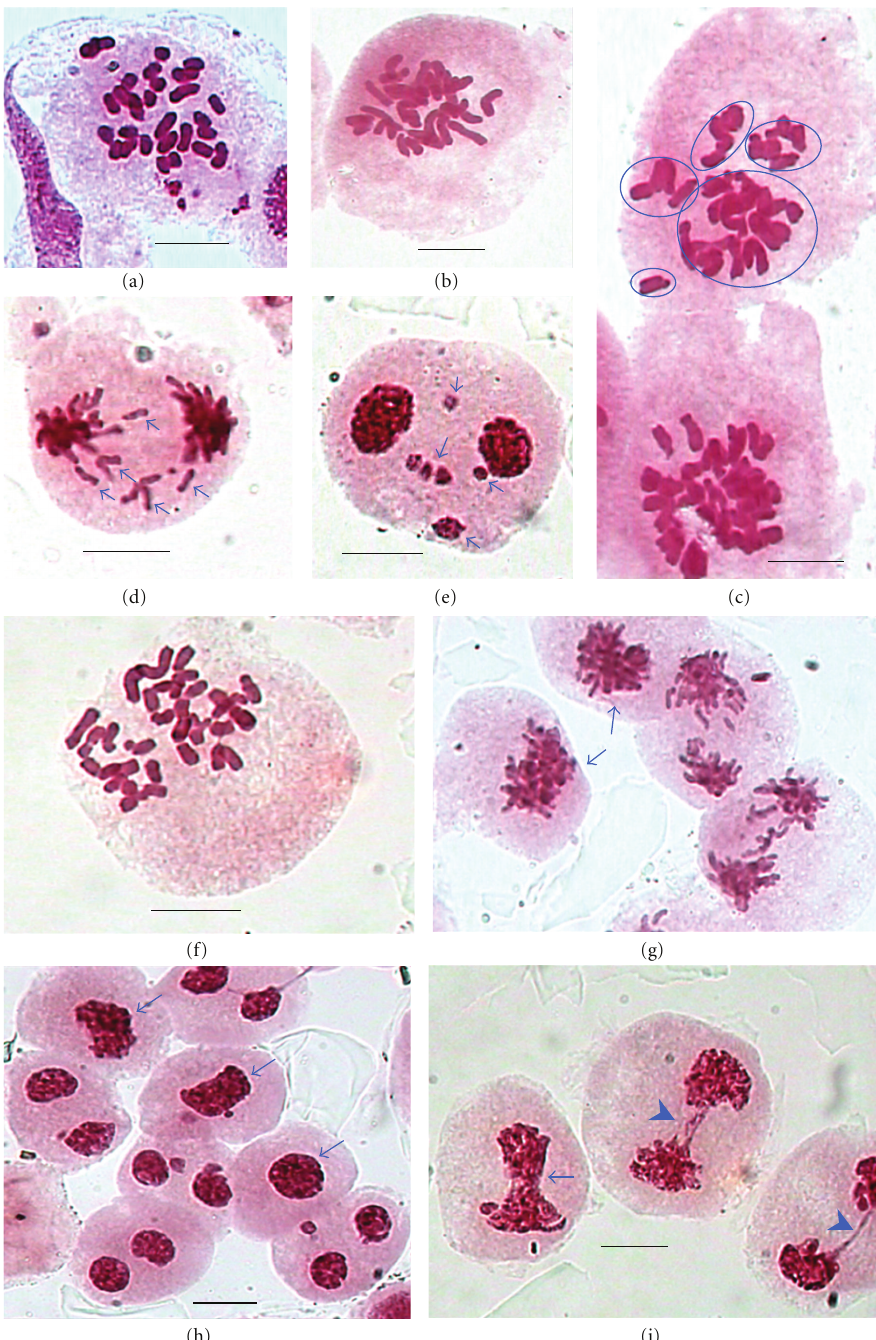
Figure 3: (a–i) Meiocytes with erratic male meiosis at first meiotic division in R. laetus. (a) A PMC with 28 randomly dispersed univalent chromosomes at M-I. (b) 28 univalent chromosomes positioned towards the periphery of PMC at M-I. (c) In one of the PMC univalent chromosomes lying in groups (encircled) and in an adjacent PMC in a single group in the centre. (d) A PMC at A-I with lagging chromosomes (arrowed). (e) Micronuclei at T-I (arrowed). (f) Unequal distribution of chromosomes (11 :17) at A-I. (g) Restitution nuclei at A-I (arrowed). (h) Restitution nuclei at T-I (arrowed). (i) Thick (arrowed) and thin (arrowhead) chromatin bridge at T-I. Scale bar = 10 µ